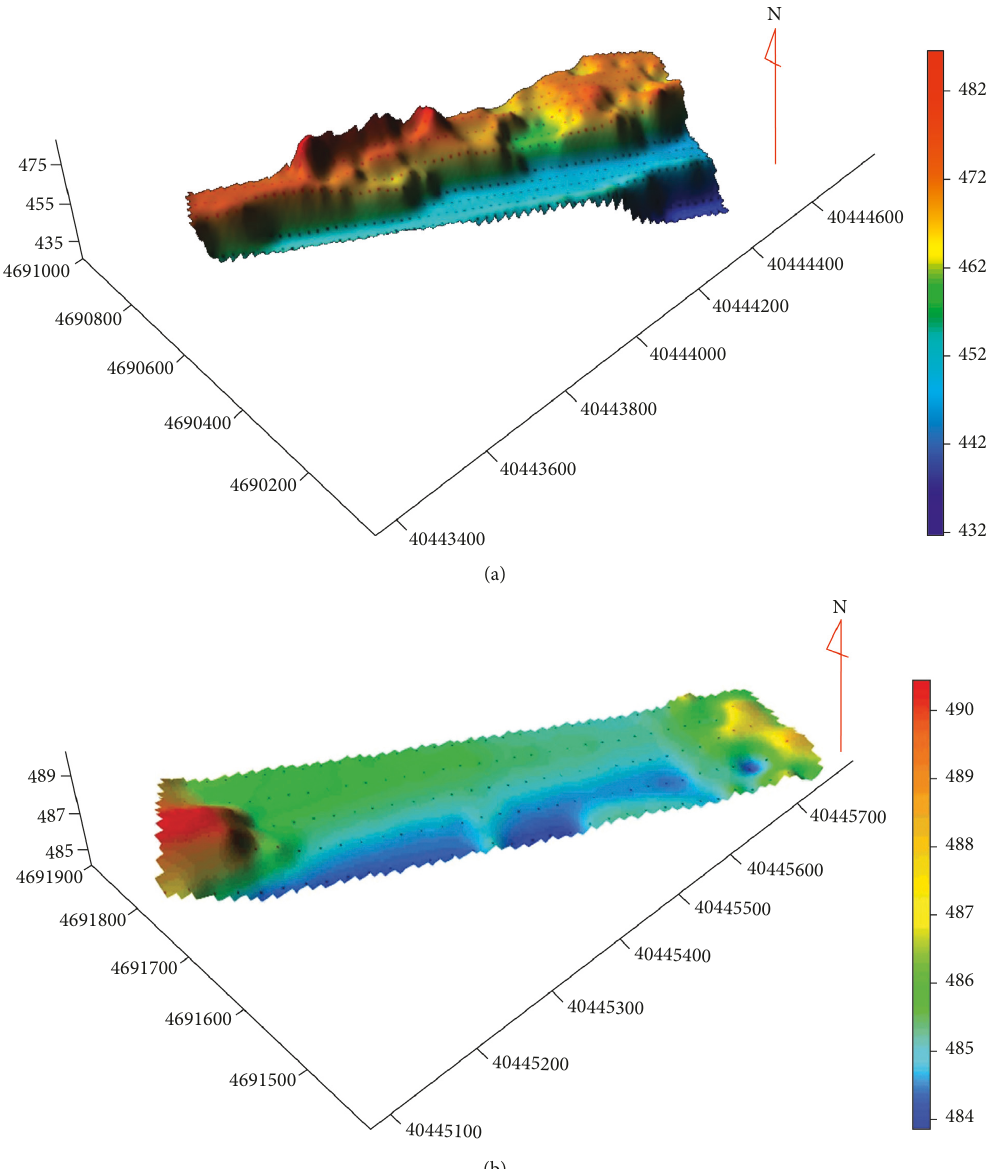
Figure 5: Surface topographic map of exploration area. (a) Topography of exploration area A. (b) Topography of exploration area